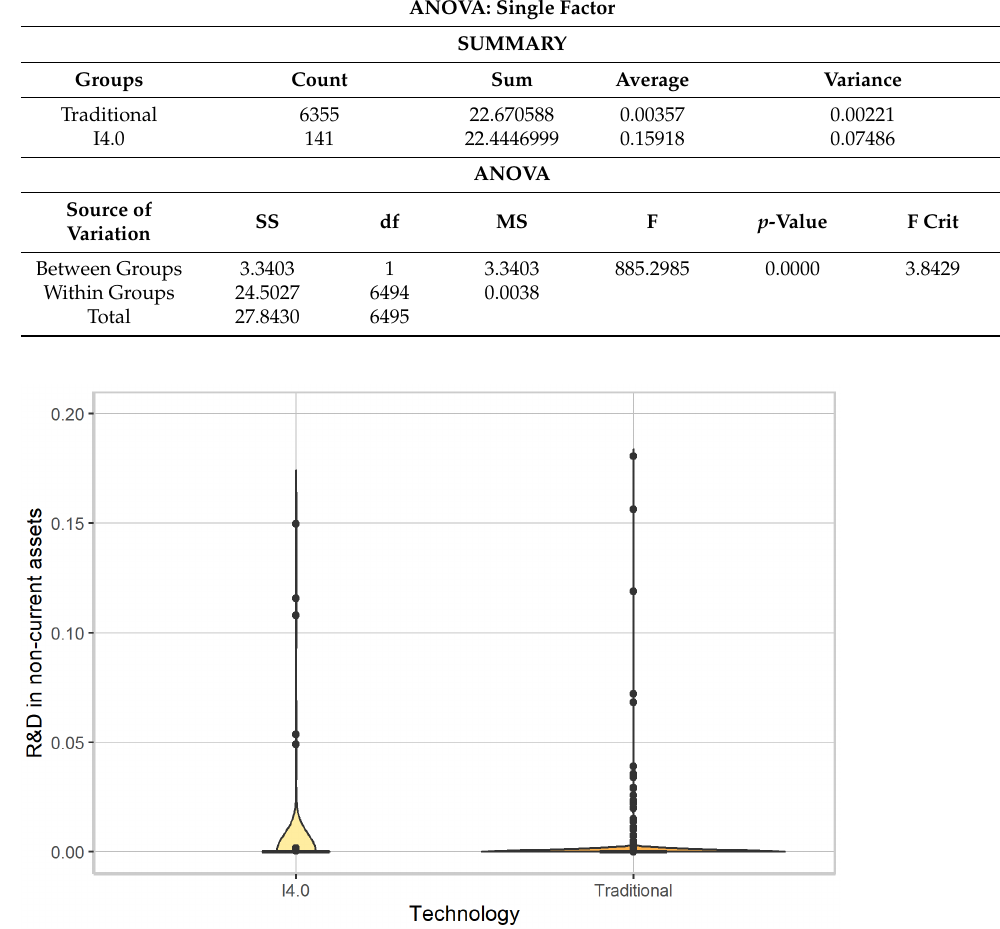
Figure 11. Distributions of the share of research and development in long-term assets. Table 8. ANOVA of the share of investment in research and development in long-term assets .